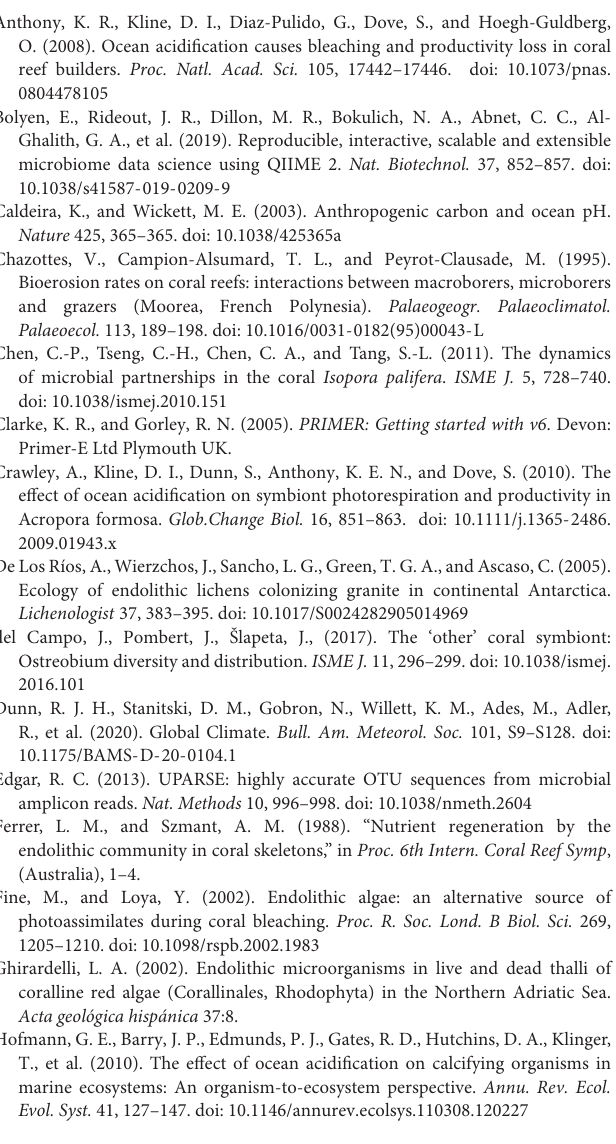
Supplementary Figure 1 | Non-metric multidimensional scaling (nMDS) analysis of the changing endolithic bacterial community in the (A) Isopora palifera and (B) Porites lobata colonies. The gray indicates coral colonies under 400 ppm p CO 2 (control) and the pink indicates colonies under 1,000 ppm p CO 2 . The triangle and